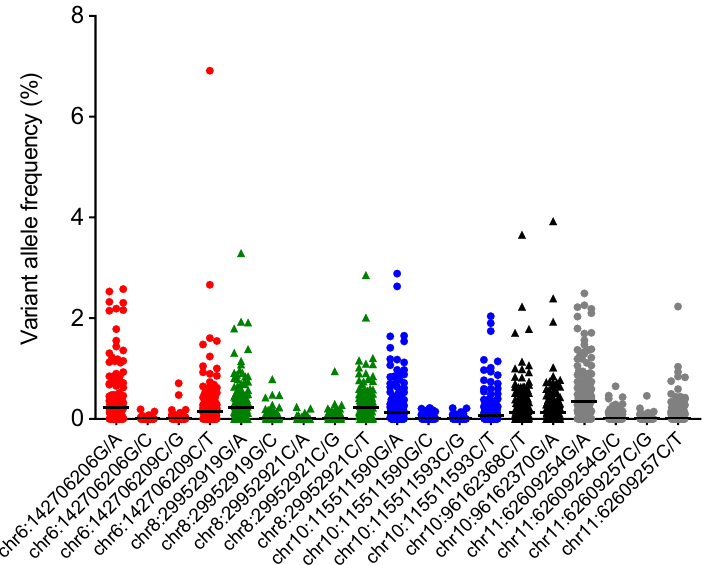
Figure 1. Variant allele frequencies at non-coding mutation hotspots in urine cpDNA from haematuria clinic non-BC patients. Red circles = ADGRG6 , green triangles = LEPROTL1 , blue circles = PLEKHS1 , black triangles = TBC1D12 , grey circles = WDR74 . Data are shown for the training set (n = 142). Horizontal bars represent median